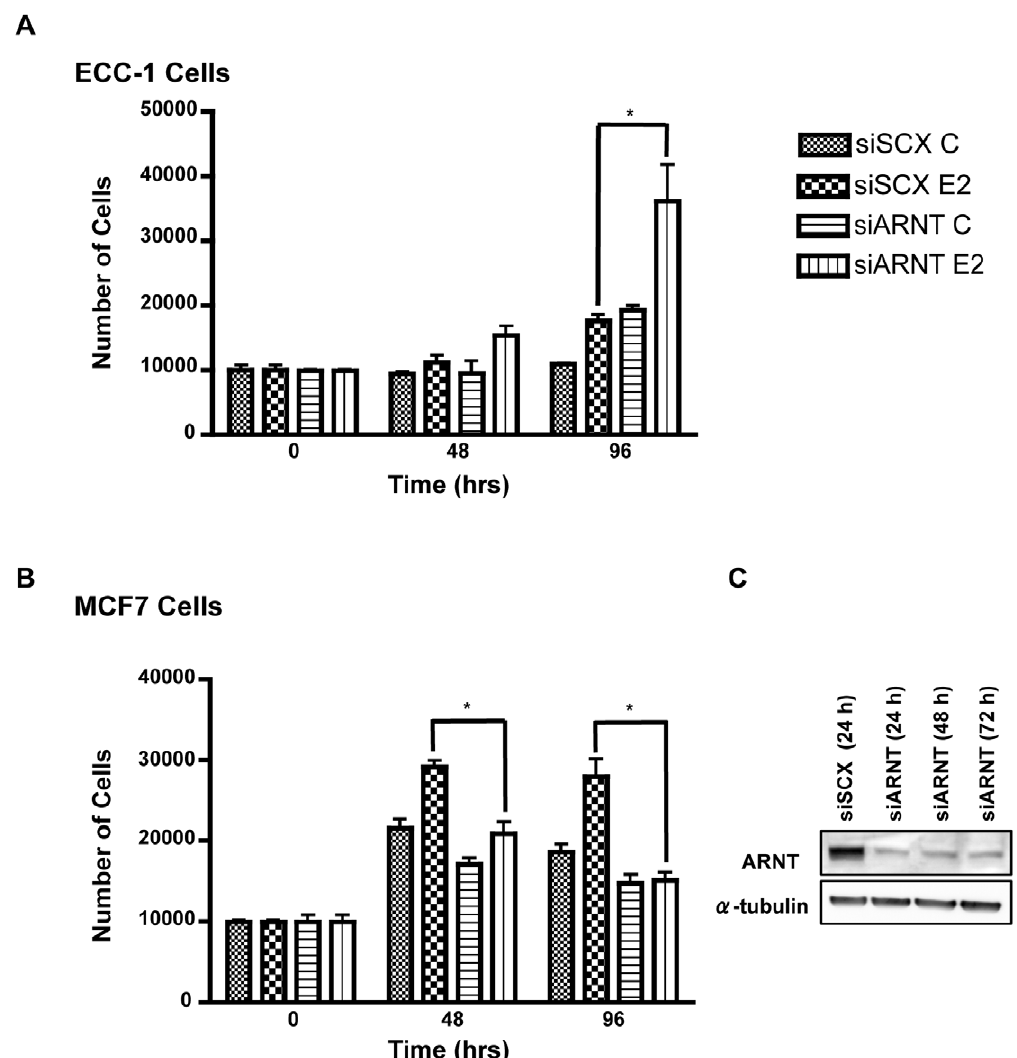
Figure 5. Loss of ARNT promotes cell proliferation in ECC-1 cells and attenuates growth in MCF7 cells. ECC-1 ( A ) and MCF7 ( B ) cells were transfected with either siSCX or siARNT for 6 hours, then trypsinized and reseeded at 10,000 cells/well in 12-well dishes. Twenty-four hours after seeding, cells were treated with either DMSO or E2 (10 nM) and cell counts were conducted at 0, 48 and 96 hours after treatments with a Fuchs- Rosenthal Counting Chamber. At the 48 h time point, cells were treated a second time with 10 nM E2. Experiments were done in triplicate and each trial was counted three times. ( C ) Western blot analysis of ARNT after siRNA knock-down reveals that significant knock-down was achieved and persists over a 72 h period. Error bars represent 6 S.D. * p ,